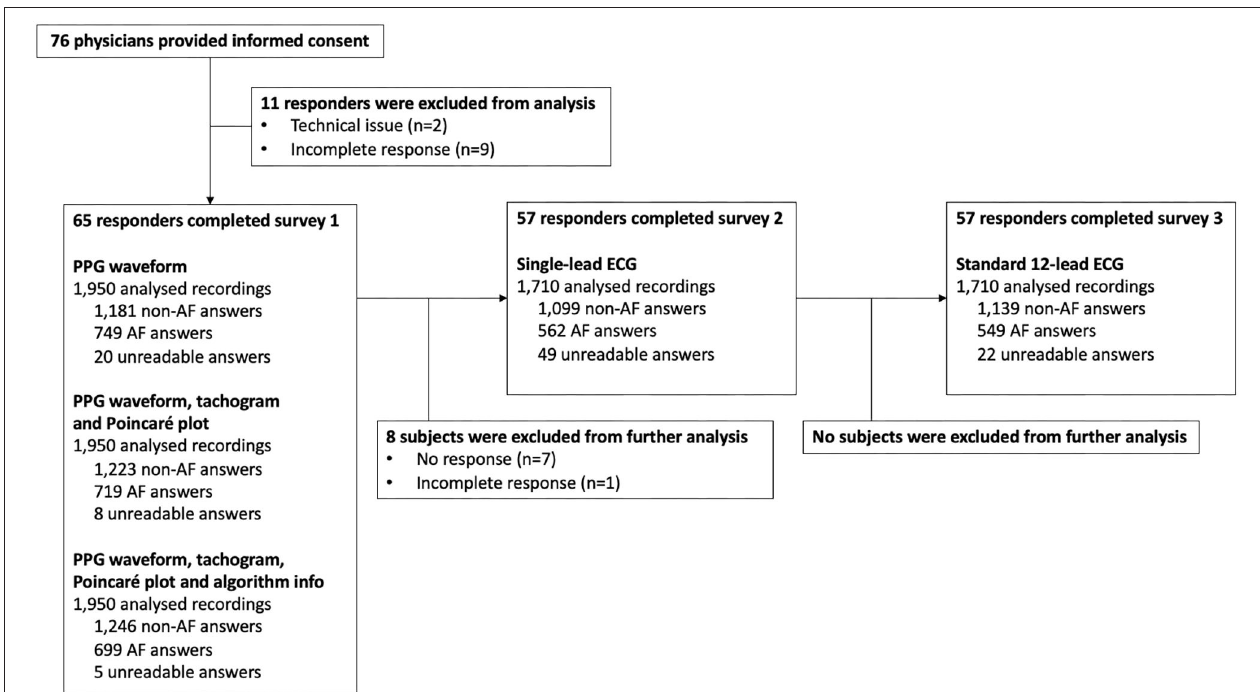
FIGURE 2 | AF, atrial fibrillation; ECG, electrocardiography; PPG, photoplethysmography.